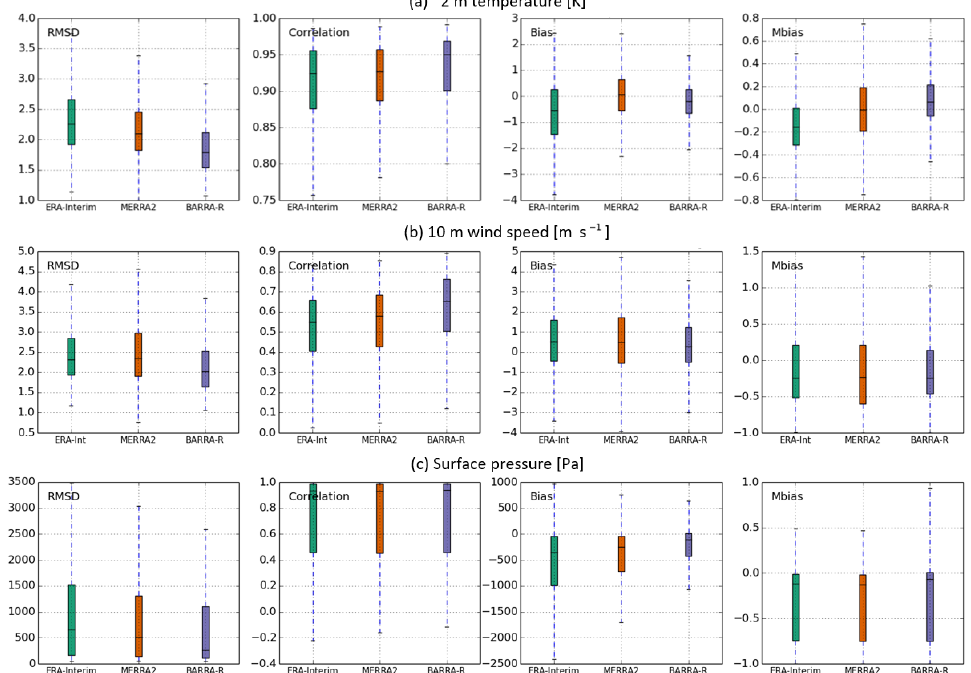
Figure 3. Box plots showing the distribution of ERA-Interim, MERRA-2, and BARRA-R evaluation scores for (a) 2m temperature, (b) 10m wind speed, and (c) surface pressure over all stations in the BARRA-R domain. The scores are calculated on model forecasts valid between t 0 + 5h and t 0 + 7h against observations during 2007–2016. Individual boxes show the interquartile range of the scores, medians are marked in each box, and “whiskers” cover the 5th–95th percentile range.